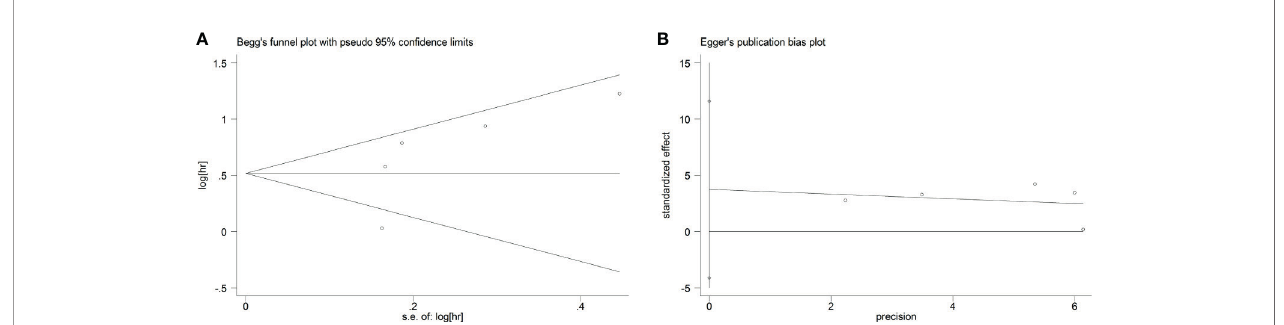
FIGURE 8 | Begg ’ s (A) and Egger ’ s (B) tests to detect publication bias in studies of HCV and GC.